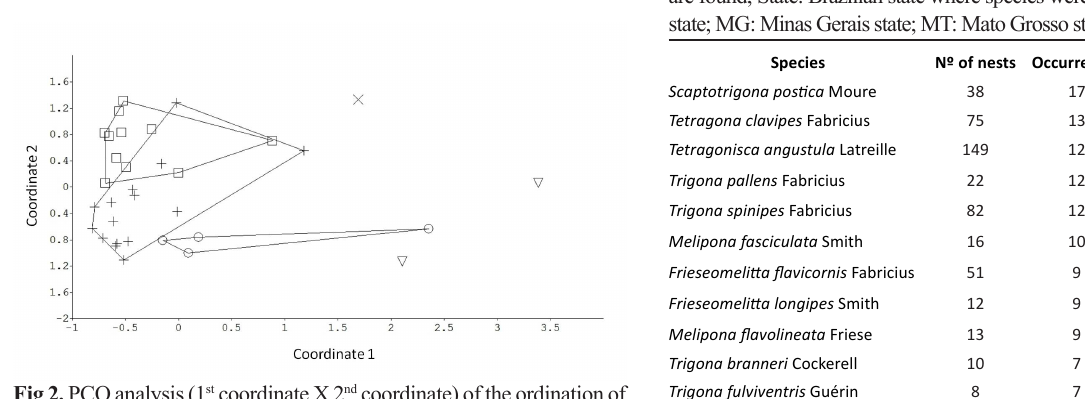
Fig 2. PCO analysis (1 st coordinate X 2 nd coordinate) of the ordination of sites by the presence-absence species data. Circle: São Paulo; triangle: Minas Gerais; x: Mato Grosso; square: SW of Maranhão; cross: NE of Maranhão.